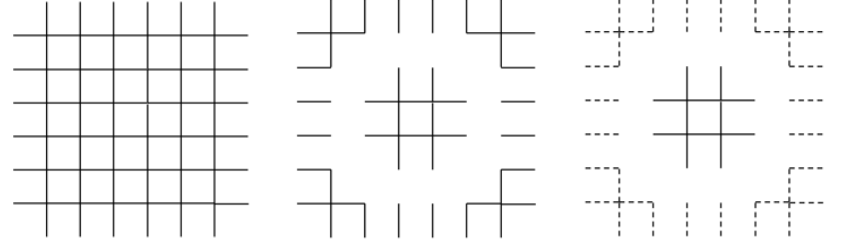
Figure 14 . Some algebra choices of gauge (cid:12)eld with matter. The (cid:12)gures correspond to square regions of size n = 5. By (cid:12)xing all the matter (cid:12)eld operators on the vertices, all operators on the links are physical. In the left (cid:12)gure, we keep all the physical degrees of freedom and get the algebra of trivial center. We denote it as B . In the middle (cid:12)gure, we remove some links. In the remaining links, both operators ~ A and (cid:25) are there. It also forms an algebra of trivial center. We denote it as ~ B . In the right (cid:12)gure, links with solid lines mean both the corresponding operators ~ A and (cid:25) belong to the algebra and links with dashed lines mean the corresponding operator ~ A or (cid:25) does not belong to the algebra. Without loss of generality, let us assume operators ~ A to be on the dashed links, not (cid:25) . The operators ~ A on dashed links commute with all the operators (cid:25) on the solid links and they form a center. We denote such an algebra as B ~ A . When the dashed links correspond to operators (cid:25) , not ~ A , we get the algebra of (cid:25) center. we denote it as B (cid:25) .